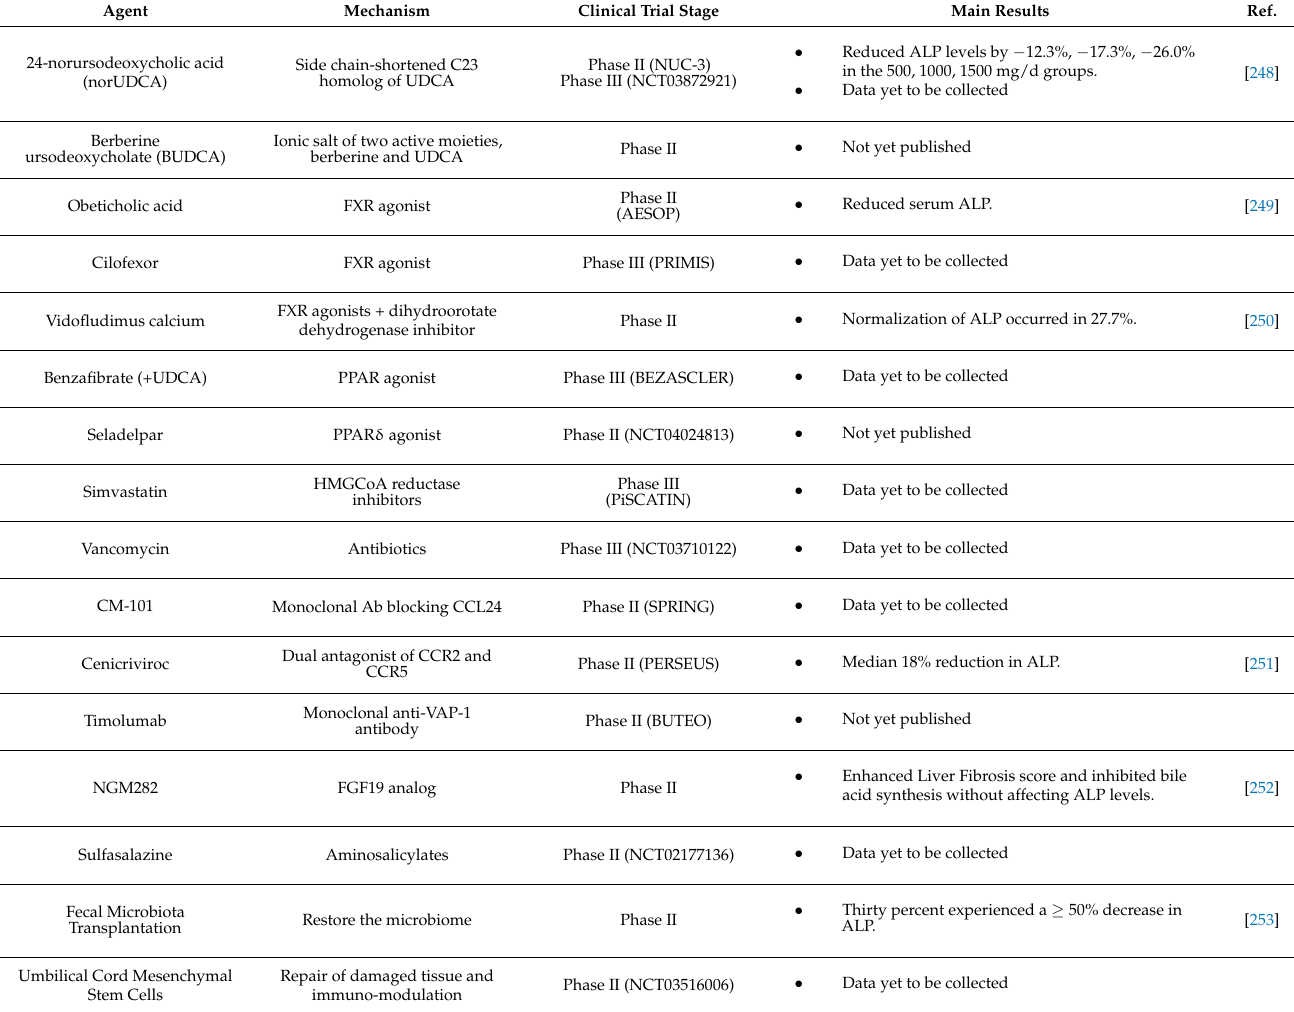
Table 3. Novel therapies currently under investigation in